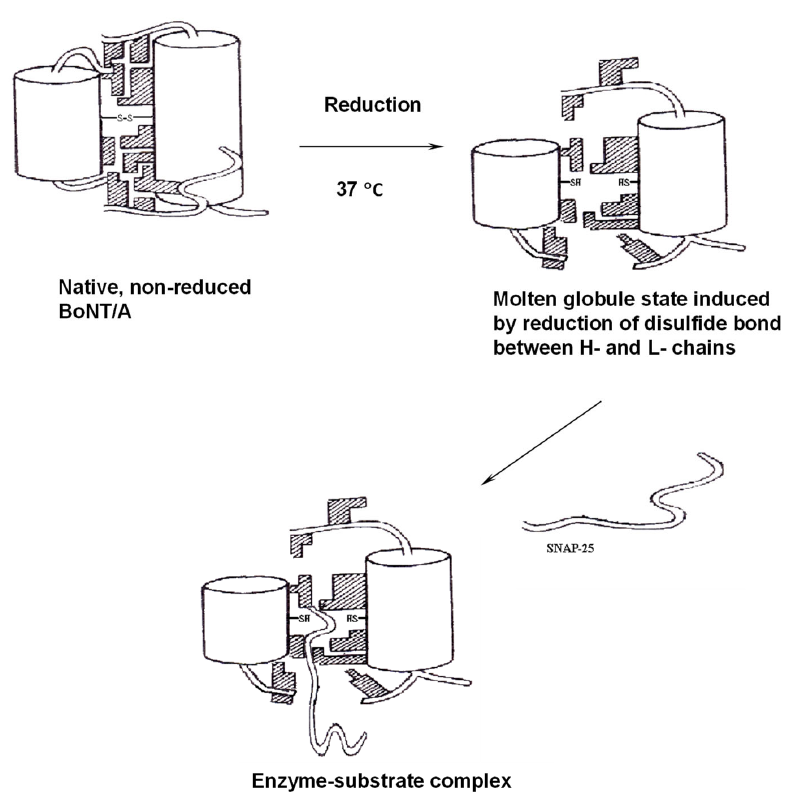
Figure 7. Schematic model of the reduction ‐ induced molten globule state of BoNT/A facilitating the binding of SNAP ‐ 25 [212].